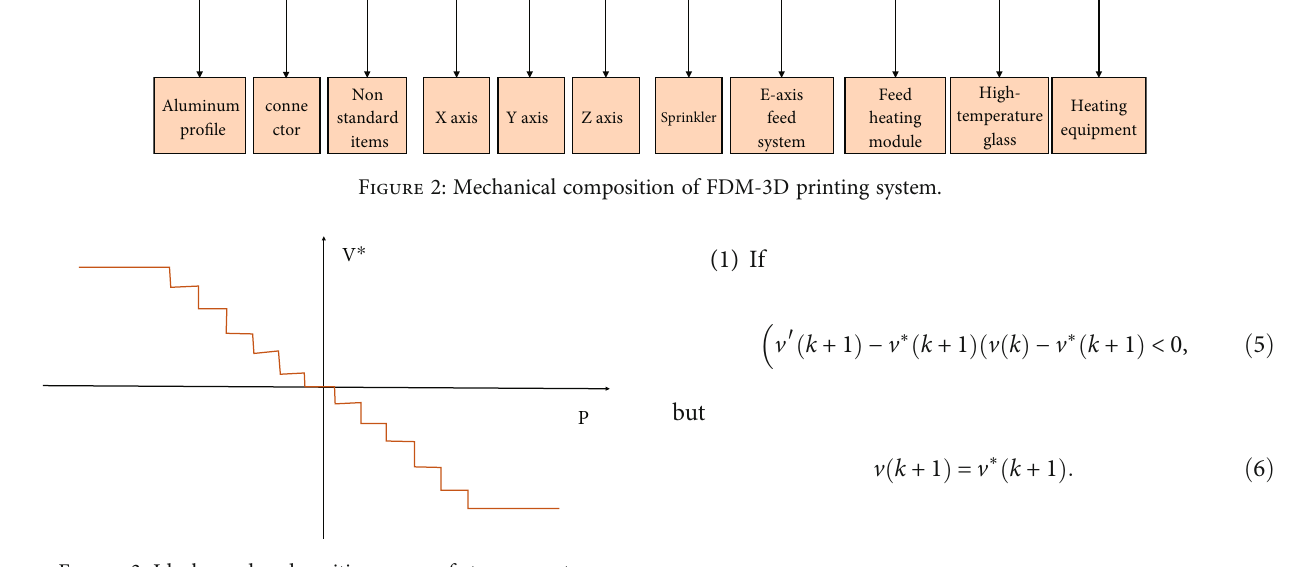
Figure 3: Ideal speed and position curve of stepper